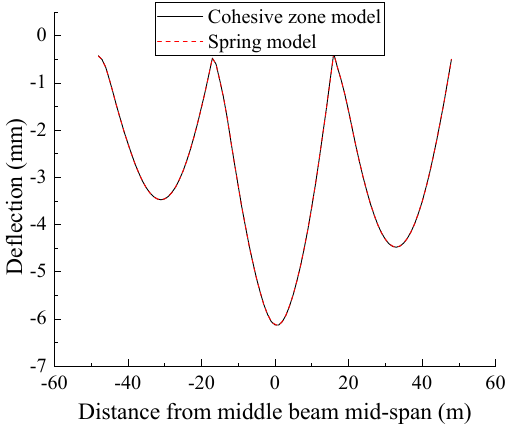
Figure 8. Beam and rail deflection curve under static loading.